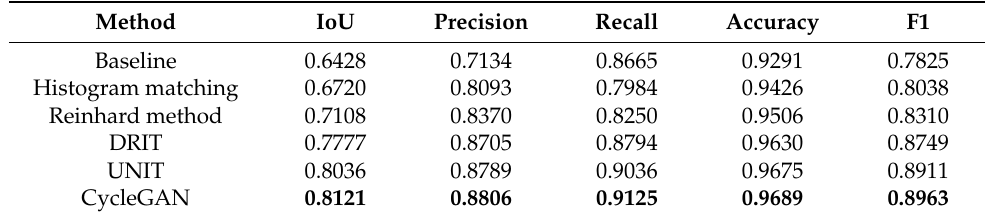
Table 2. Evaluation metrics of the semantic segmentation results obtained by different image color translation methods on the Beijing Huairou district land survey dataset.